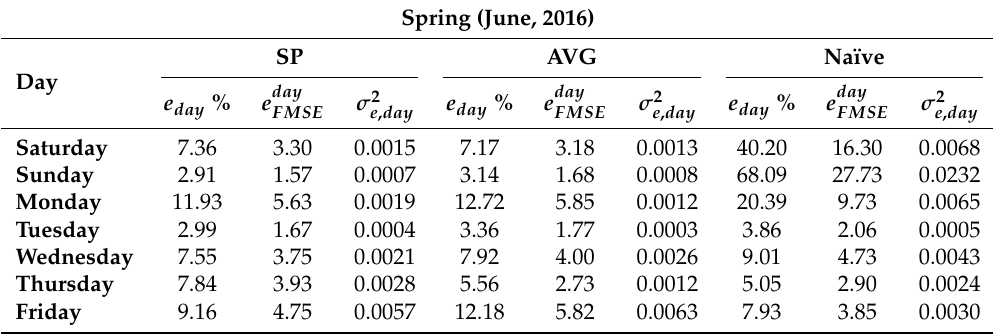
Table 8. e day (%), e day and σ 2 of spring of 2016, 2015 and 2014 for the SP model, average and FMSE e , day naïve